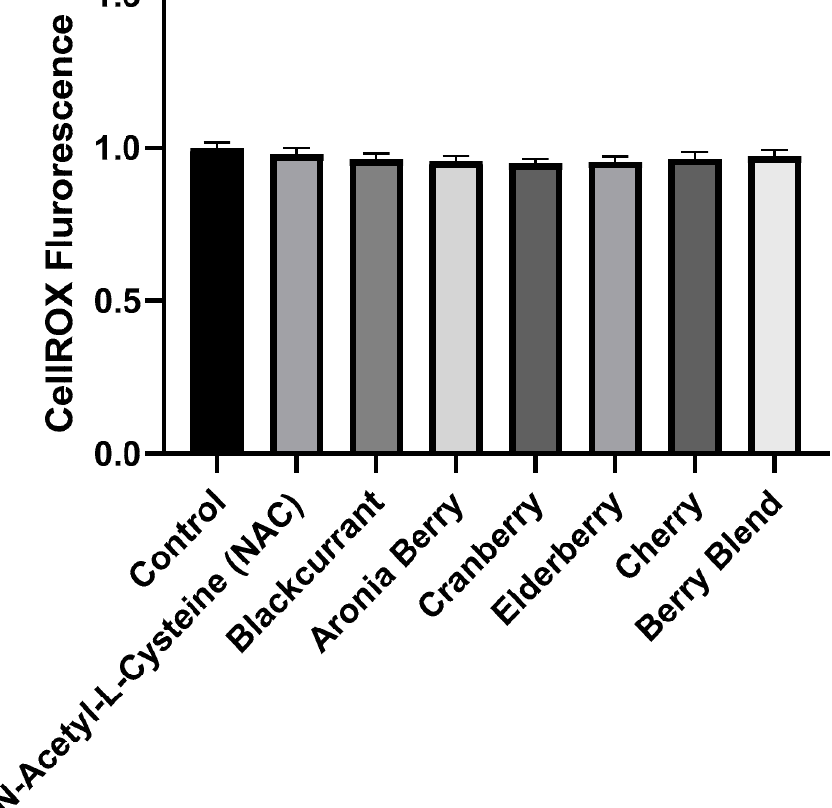
Figure 1. Effects of berry extracts (1 µg/mL) on oxidative stress in HL-1 cells. Mean (+ specify if SEM or SD) normalized CellROX TM fluorescence from experiments ( n = 3) demonstrating the effect of berry extracts on basal oxidative stress in HL-1 cardiomyocytes. In each experiment, CellROX TM fluorescence was normalized to the control. There were no significant effects ( p > 0.05) of NAC or any of the berry extracts on CellROX TM fluorescence in the absence of an oxidative stress-inducing agent. Next, the ability of the berry extracts to counteract the oxidative stress induced by menadione (also known as vitamin K3) was determined. As shown in Figure 2, K3 induced a marked increase in CellROX TM fluorescence. As expected, pretreatment with the potent antioxidant, NAC, significantly inhibited K3-induced oxidative stress ( p < 0.001). Among the berry extracts, only black currant extract significantly reduced oxidative stress induced by K3 ( p = 0.037). In contrast, none of the other berry extracts inhibited K3-induced oxidative stress. For example, oxidative stress in the presence of K3 + cranberry extract was nearly identical to treatment with K3 alone. Based on these results, black currant and cranberry extracts were selected for further investigation to better understand the differences between the radical scavenging activity of these particular berry extracts and their